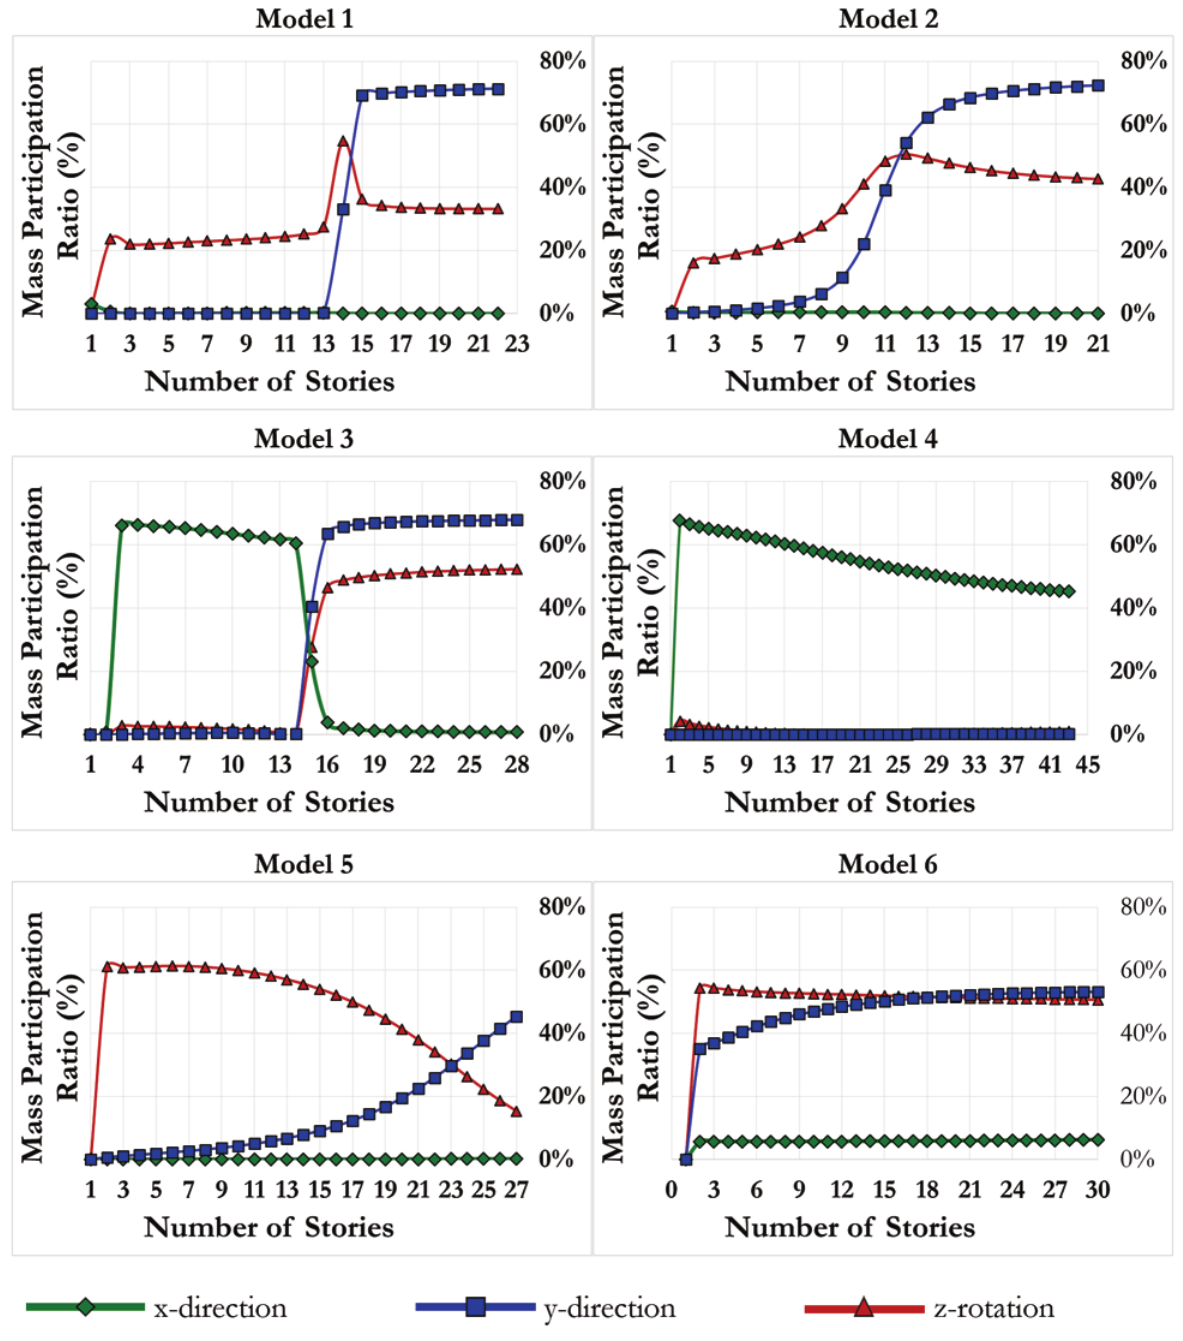
Figure 8 Effective modal mass of the first mode of vibration for models 1, 2, 3, 4, 5 and